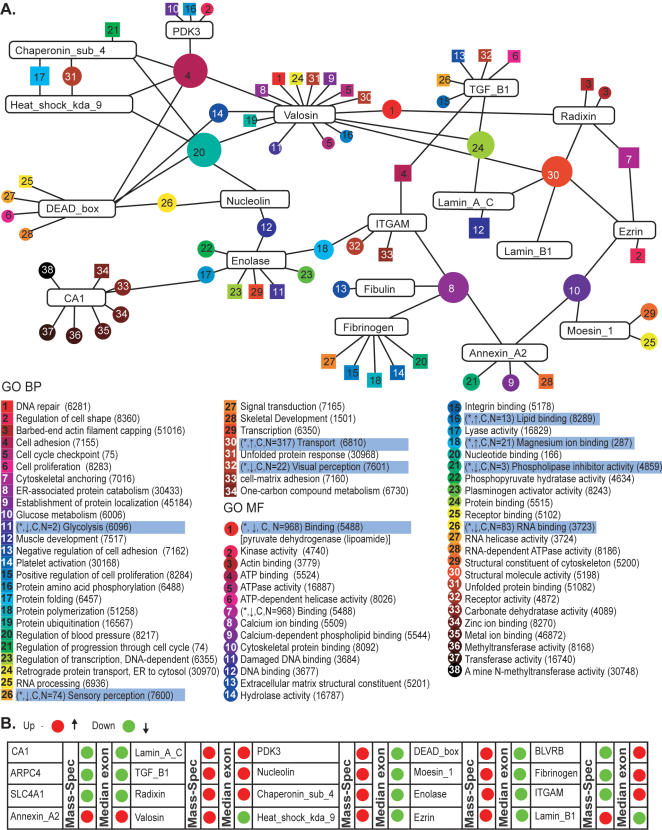
Proteomic Analysis Combined with Exon Array Data Indicates Possible Alternative Splicing and Overlaps with Changed GO Categories.Functional MF (circles) and BP (rectangles) GO term networks of selected changed proteins. The relative shape size (i.e circles and rectangles) indicates the number of connected proteins. Note the complex connections between proteins sharing common GO categories. Some of these categories changed according to the continuous exon array analysis as well. Comparison between protein and gene levels for proteins detected as changed using 1D MS analysis. Ninety-one changed proteins were detected using K-means clustering on the peptide signals information (supplementary methods). Relative signals for selected proteins were calculated from the mean number of peptides detected in MG-thymoma and healthy Thymus samples, and compared to the median exonic expression level of the corresponding genes as detected by the exon arrays. In some, both decreased, in some both increased and in the rest, opposite changes occurred.